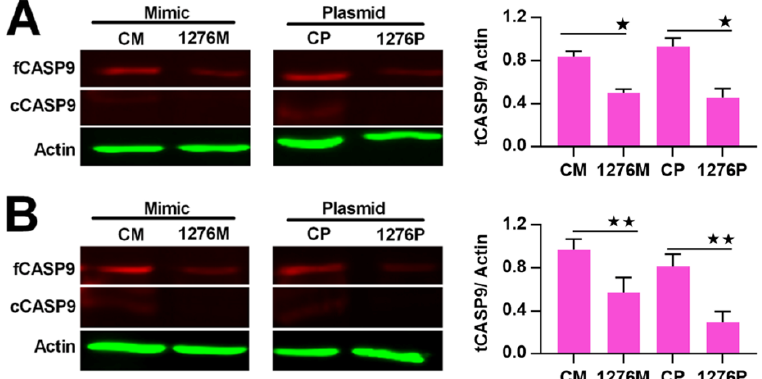
Figure 6. Regulation of CASP9 by miR1276 at the protein level. (A) and (B) Expression of CASP9 protein in HeLa cells (A) and HepG2 cells(B) transfected with miR1276 mimic or expression vector. The data are presented as the means ± SD from three independent experiments. fCASP9, cCASP9, tCASP9 and the calculation of tCASP9/actin; see Figure 4. CM, control mimic; 1276M, miR1276 mimic; CP, control plasmid; 1276P, miR1276 expression plasmid. The significance of the differences was analyzed by Student ′ s t ‐ test. * p < 0.05; ** p < 0.01.